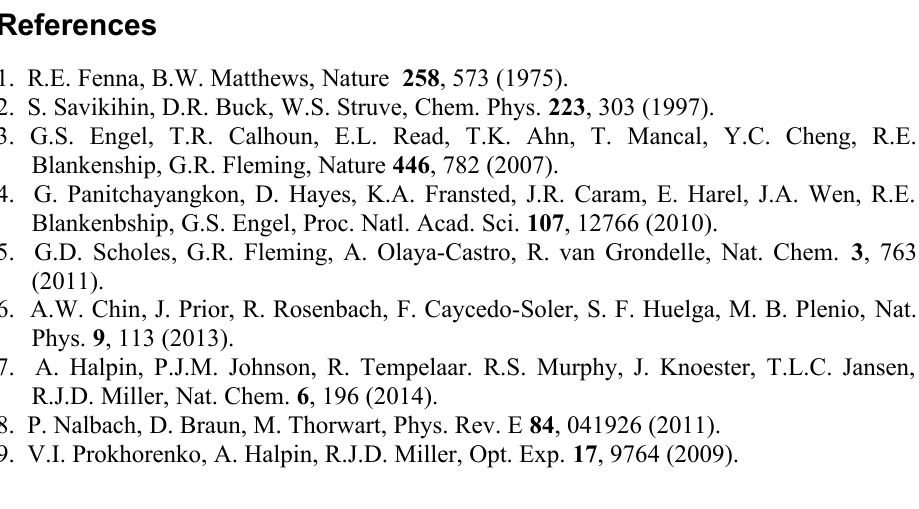
Fig. 2. Left: Time-evolved amplitude (real and imaginary) of the selected peak “X” in Fig. 1. Right: Lifetime of the electronic coherence in the LHCII, PSII reaction center, indocabocyanine dimer and FMO protein